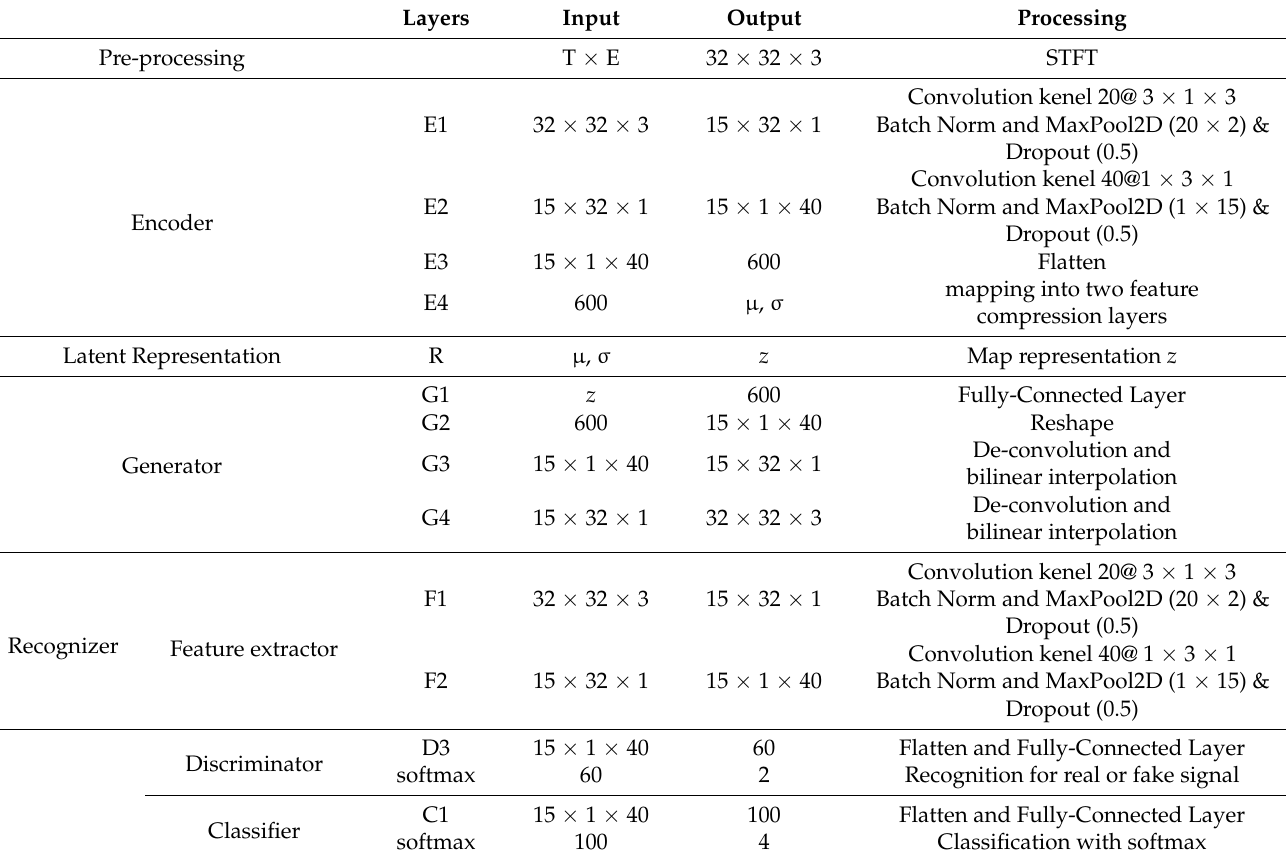
Table 2. Implementation details for the proposed CVAE-GAN